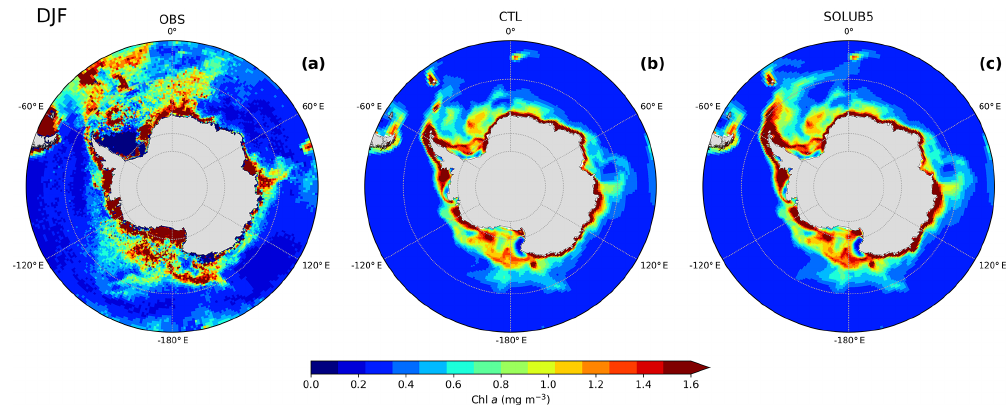
Figure 8. Surface chlorophyll concentrations in summer (December, January, and February) from (a) satellite observations (MODIS Aqua; Johnson et al., 2013), (b) the CTL experiment, and (c) the SOLUB5 experiment in the Southern Ocean, south of 50 ◦ S.